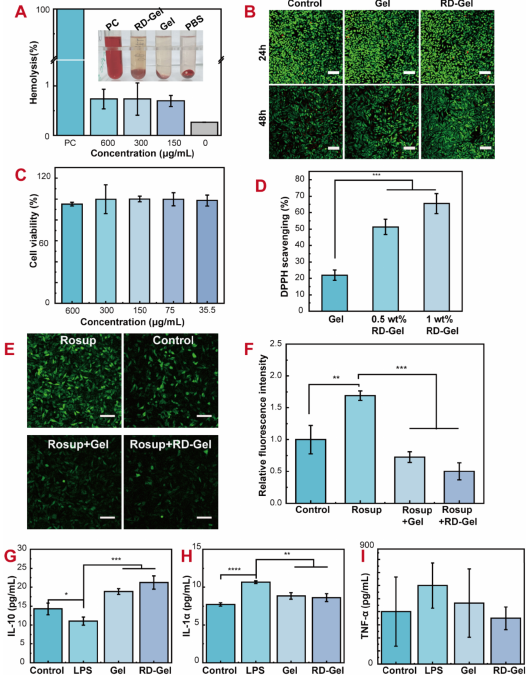
Figure 3. Cytocompatibility, antioxidant and anti-inflammatory properties of hydrogels in vitro. ( A ) Hemolytic test of different hydrogels with blood samples. The X-axis refers to the concentrations of the RD-Gel co-incubated with the blood cells. ( B ) Cytocompatibility of hydrogels indicated by live/dead staining. Scale bar: 100 µ m. ( C ) Cell viability of L929 following incubating with hydrogel extracts for 48 h. ( D ) DPPH scavenging percentage for the treatments with Gel and RD-Gel. ( E ) The intracellular ROS level indicated by DCFH-DA probe. Scale bar: 100 µ m. ( F ) The quantitative analysis of intracellular ROS depletion. ( G ) Expression of inflammatory factors: IL-10. ( H ) Expression of inflammatory factors: IL-1 α . ( I ) Expression of inflammatory factors: TNF- α . For statistical analysis, ∗ represents p < 0.05, ** represents p < 0.01, *** represents p < 0.001, **** represents p <